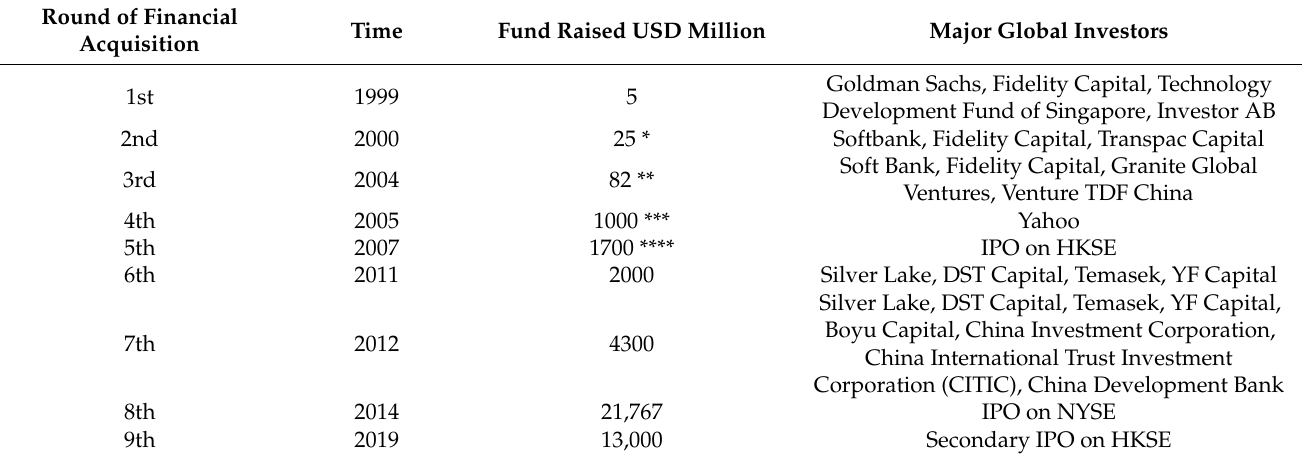
Table 2. Nine Rounds of Alibaba’s Equity-based Fundraising from Financial Markets outside